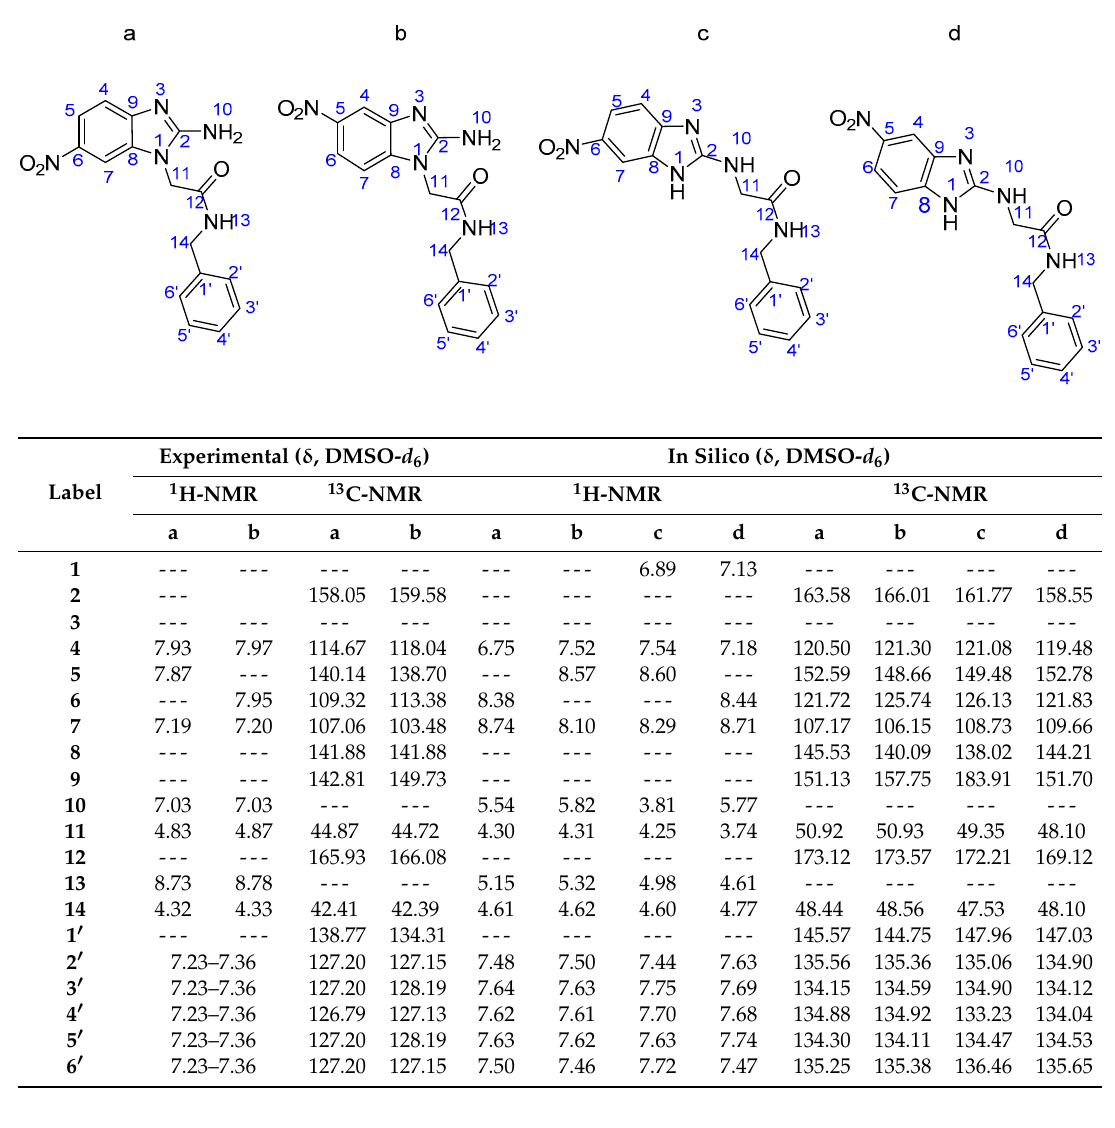
Table 3. NMR predictions for reigoisomers and tautomer compounds.